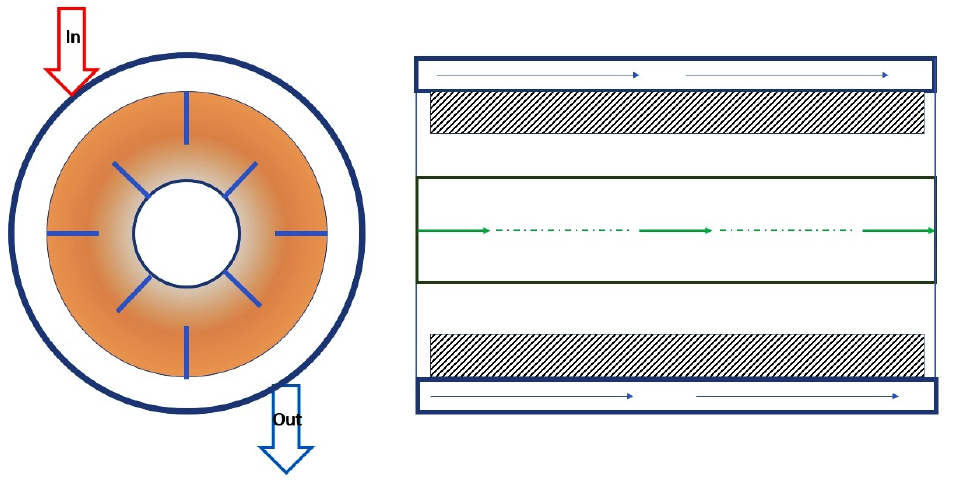
Figure 4. Cross Section and Longitudinal Section of the Heat Exchanger [55].